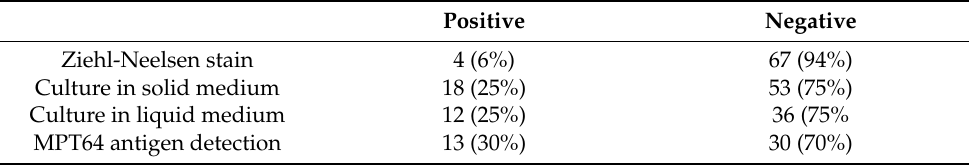
Table 3. Diagnostic yield of microbiology tests in pleural fluid of patients with tuberculous pleural